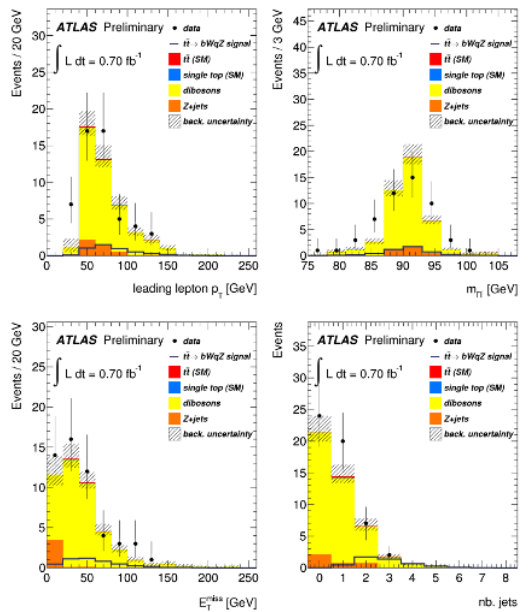
Fig. 1. Distributions obtained with the t → qZ analysis after the preselection. Transverse momentum of the leading lepton (top left), reconstructed mass of the two leptons with same flavor and opposite charge (top right); E miss (bottom left) and number of jets T (bottom right), are shown. The background uncertainties shown include the MC simulation statistical uncertainties and the DD uncertainties. The signal distributions are normalized to the ob- served BR limit, at 95% CL.